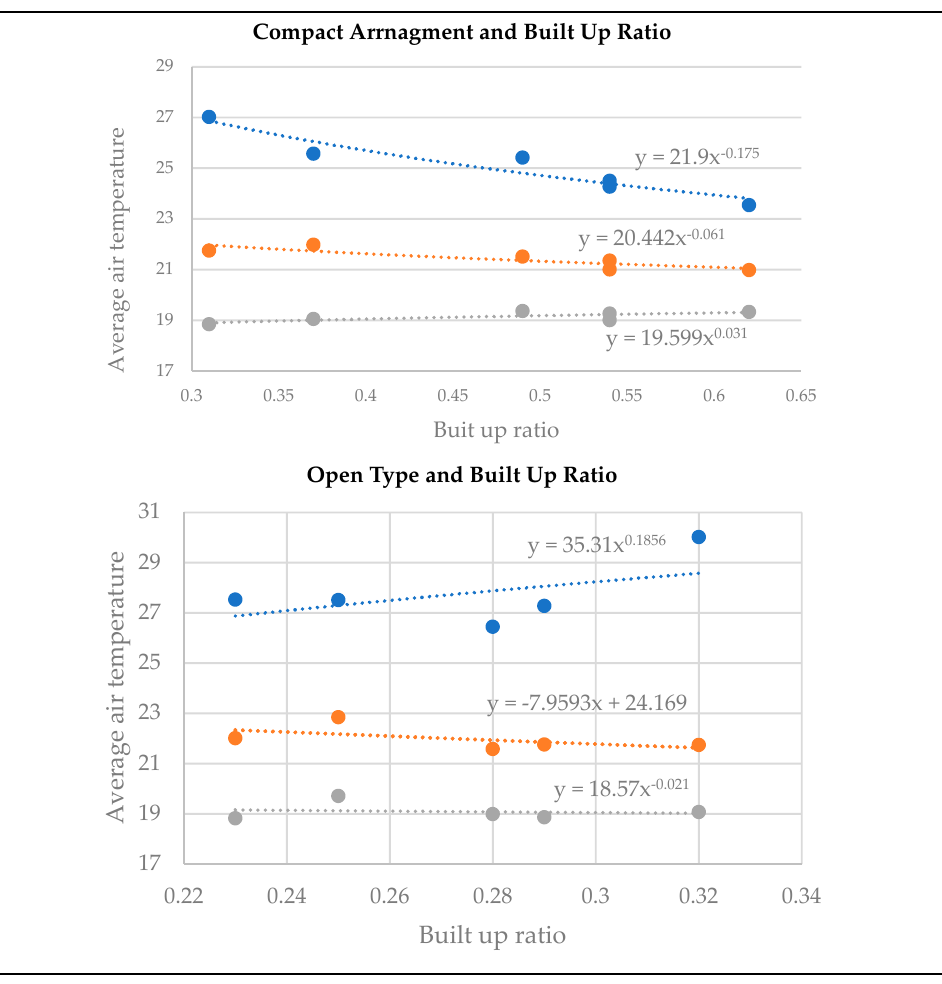
Table 18. A summary of the correlation between average air temperature and built-up ratio in open and compact type arrangements in 17 January dotted in blue, 24 January dotted in orange, 19 February dotted in grey.